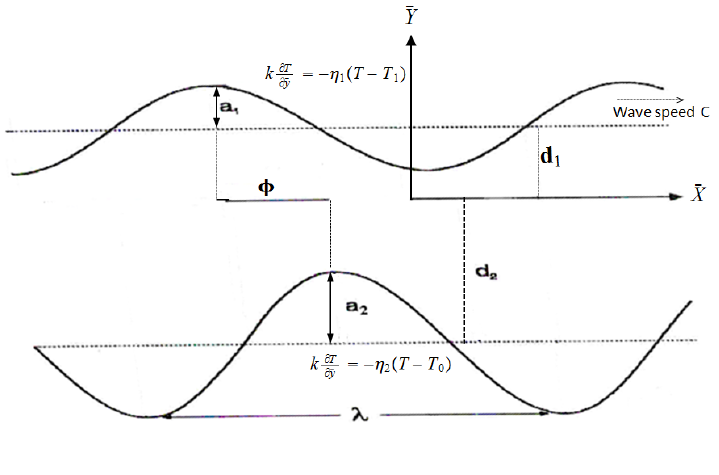
Figure 1. Geometry of the